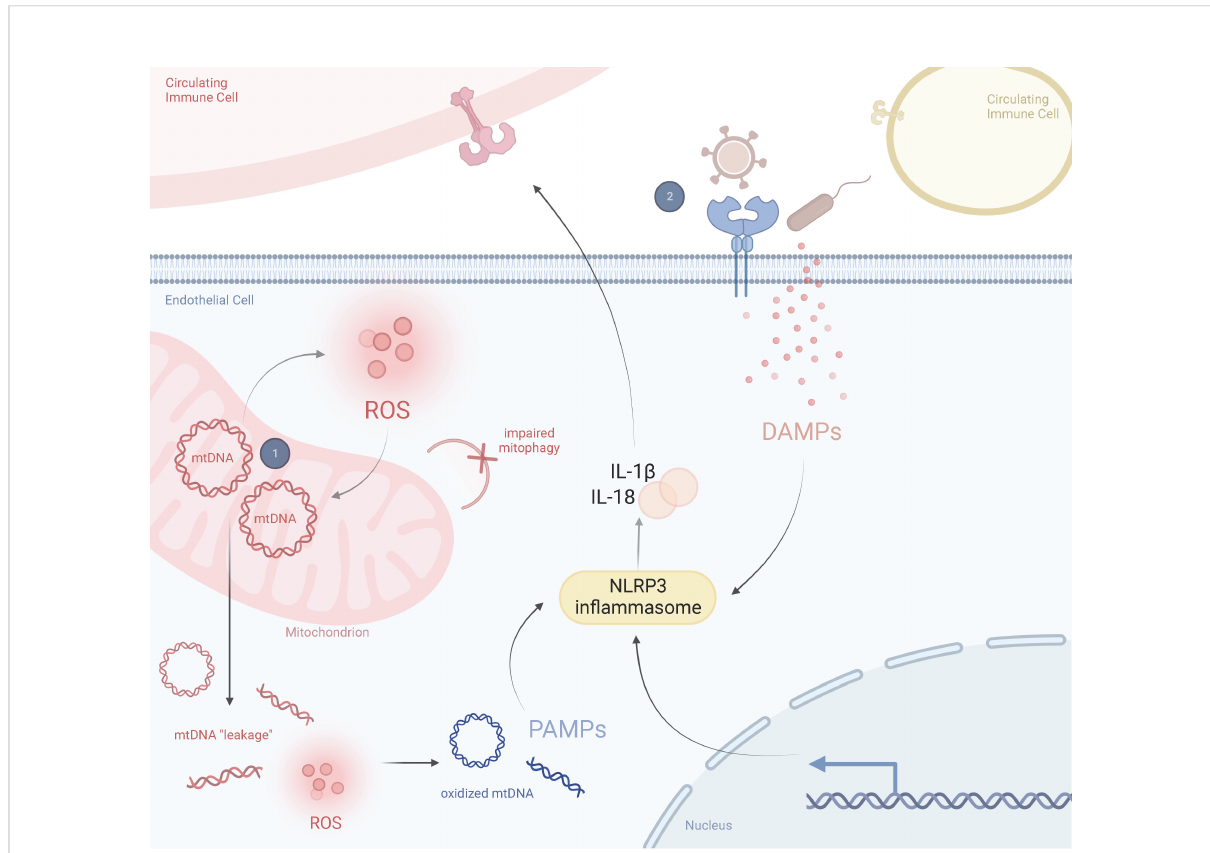
FIGURE 4 Prospective Two-Hit Model of Mitochondrial Dysfunction in Kawasaki DiseaseSchematic representation of the perspective in fl ammatory response in a healthy state and in a Kawasaki diseased state, including the role of mitochondria in driving KD responses. (1) A mitochondrial SNP or haplogroup background results in abnormally proin fl ammatory mitochondria that are more likely to release mtDNA into the cytosol and produce ROS. These ROS oxidize cytosolic mtDNA and are recognized by circulating immune cells as DAMPs. Exposure to DAMPs activates the NLRP3 in fl ammasome, leading to proin fl ammatory cytokine release, such as IL-1 b and IL-18. (2) Several viruses or bacteria manipulate mitochondria during infection. This could lead to a hyperimmune response and cytokine storm from previously damaged mitochondria (i.e., those prone to pyroptosis or impaired mitophagy). ROS and secreted cytokines further amplify this response in a feedback loop. Adapted from “ Lipids and Proteins Involved in Lipid Uptake and Metabolism in Cardiac Lipotoxicity ” , by BioRender.com. Retrieved from https://app.biorender.